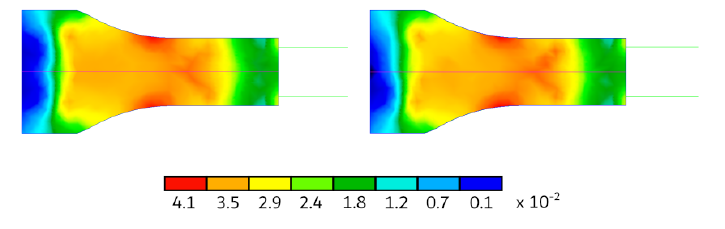
Figure 19. Failure indices in the top and bottom surfaces of the support; Maximum Stress Criterion.